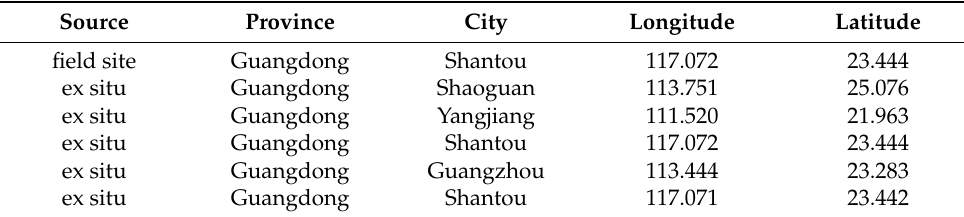
Table 1. Specimen data from our field site and ex situ reintroduction